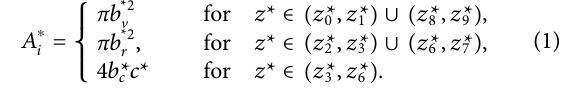
Frontiers in Mechanical Engineering |